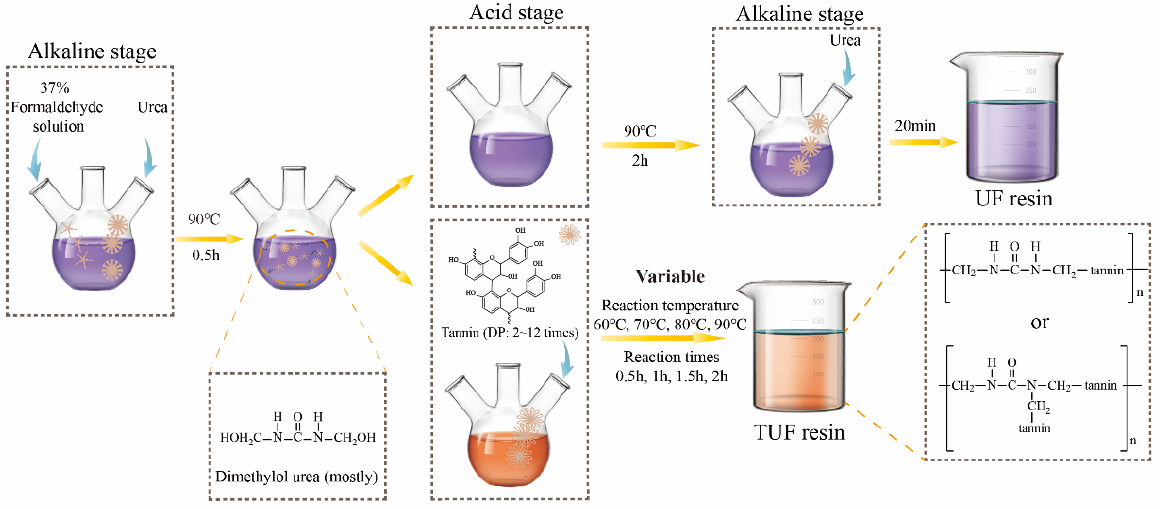
Figure 1. Synthetic steps for preparation of UF/ TUF resins.